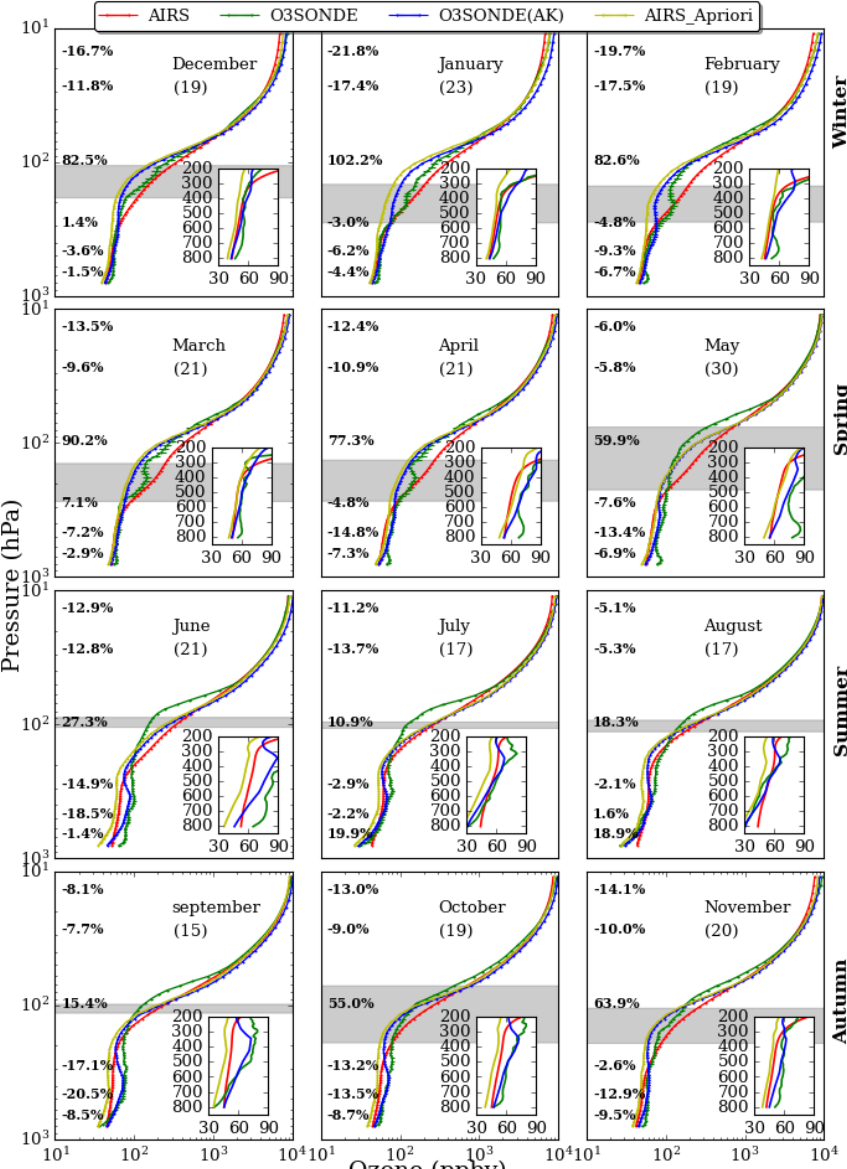
Figure 5. Monthly averaged (2011–2017) ozone profiles of ozonesonde, AIRS, ozonesonde (AK), and AIRS a priori profiles over Nainital in the central Himalayas. The percentage differences ((AIRS − ozonesonde (AK)) / ozonesonde (AK)) × 100 at 706, 496, 300, 103, 29, and 14.4hPa are also written at respective altitudes. The standard error corresponding to each profile is also shown with error bars. The number of ozonesondes for different months is written in the brackets, and the grey shaded area shows the tropopause (mean ± σ ) from balloon-borne